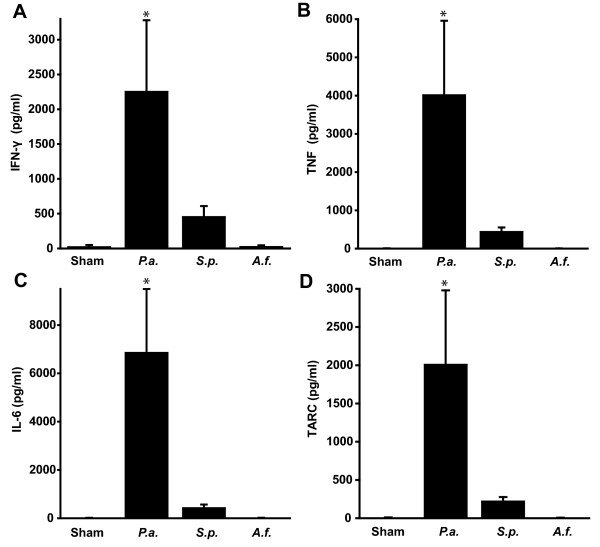
Proteomic analysis of post-challenge BAL fluid. Mice were challenged with aerosolized P. aeruginosa, S. pneumoniae, A. fumigatus or PBS (sham). 24 h later, BAL was performed and concentrations of 16 cytokines and chemokines were measured by ELISA. In all cases, P. aeruginosa induced the highest level of cytokine or chemokine expression, with no test identifying any other infectious condition. Shown are representative examples: (A) Interferon-γ, (B) tumor necrosis factor (C) Interleukin-6 and (D) CCL17. (mean ± SD, N = 5 mice/group, *p < 0.005 compared to all other conditions.